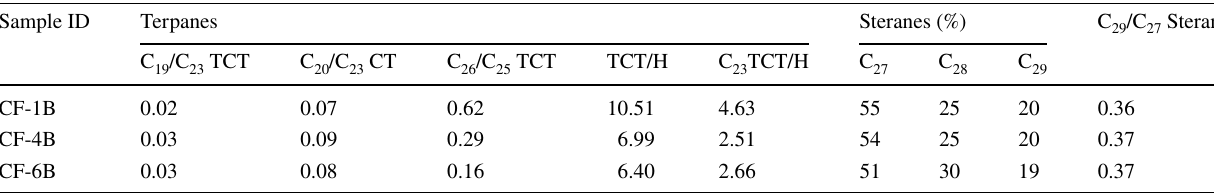
Table 7 Terpane and sterane biomarker parameters used in this